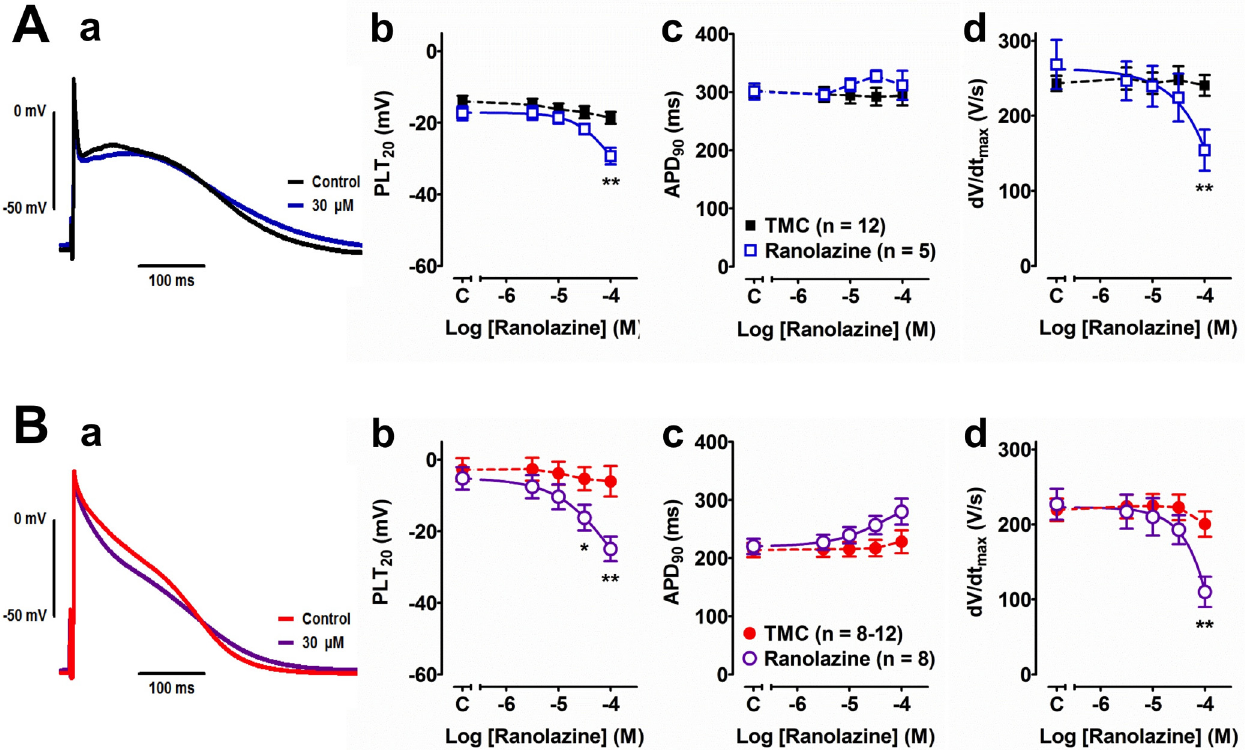
Fig 5. Effects of ranolazine on human right atrial action potentials. Action potentials were recorded in tissue from patients in SR ( Aa ) and in AF ( Ba ) under control conditions and after exposure to increasing concentrations of ranolazine. Scale bar: from 0 to -80 mV in the y axis; 100 ms in the x axis. Ab-d and Bb-d : Ranolazine effects on (blue and purple), compared to spontaneous changes in time-matched control experiments (TMC) without any drug added in plateau potential (mean potential at 20% of APD 90 plus 5 ms, PLT 20 , Ab, Bb ), on action potential duration at 90% of repolarization (APD 90 , Ac, Bc ), and maximum upstroke velocity (dV/dt max , Ad, Bd ). * P < 0.05; ** P < 0.01; unpaired Student ‘ s t